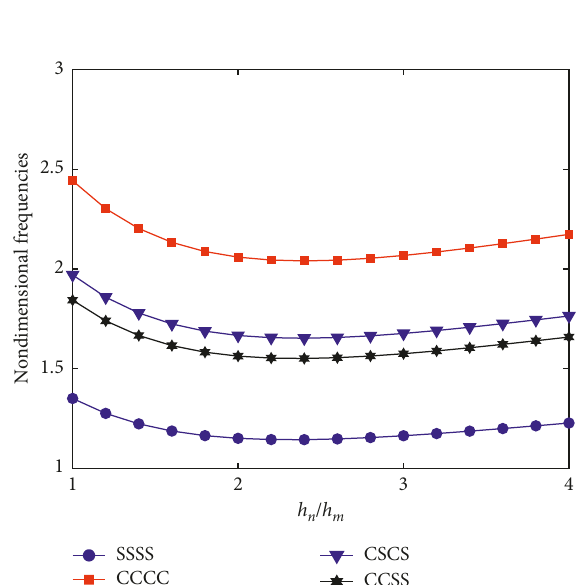
Figure 10: The effect of ratio a / b on nondimensional fundamental frequencies of the plate with h n / h m � 1 and k